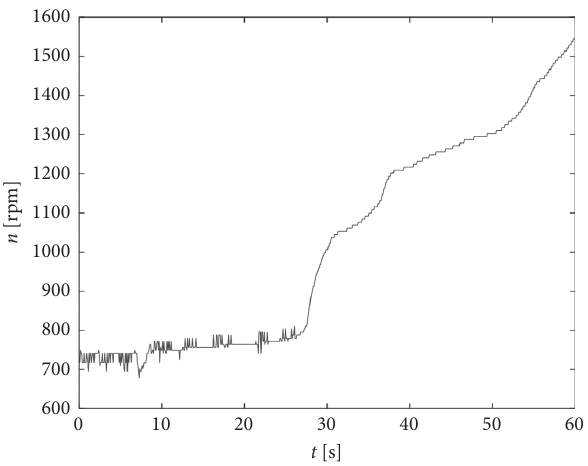
Figure 20: Reference signal from the engine rotor.